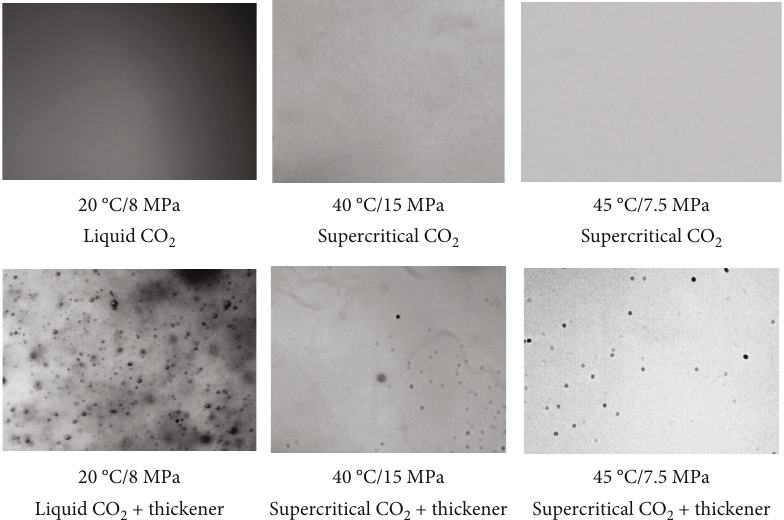
Figure 8: Dissolution of the thickener in CO